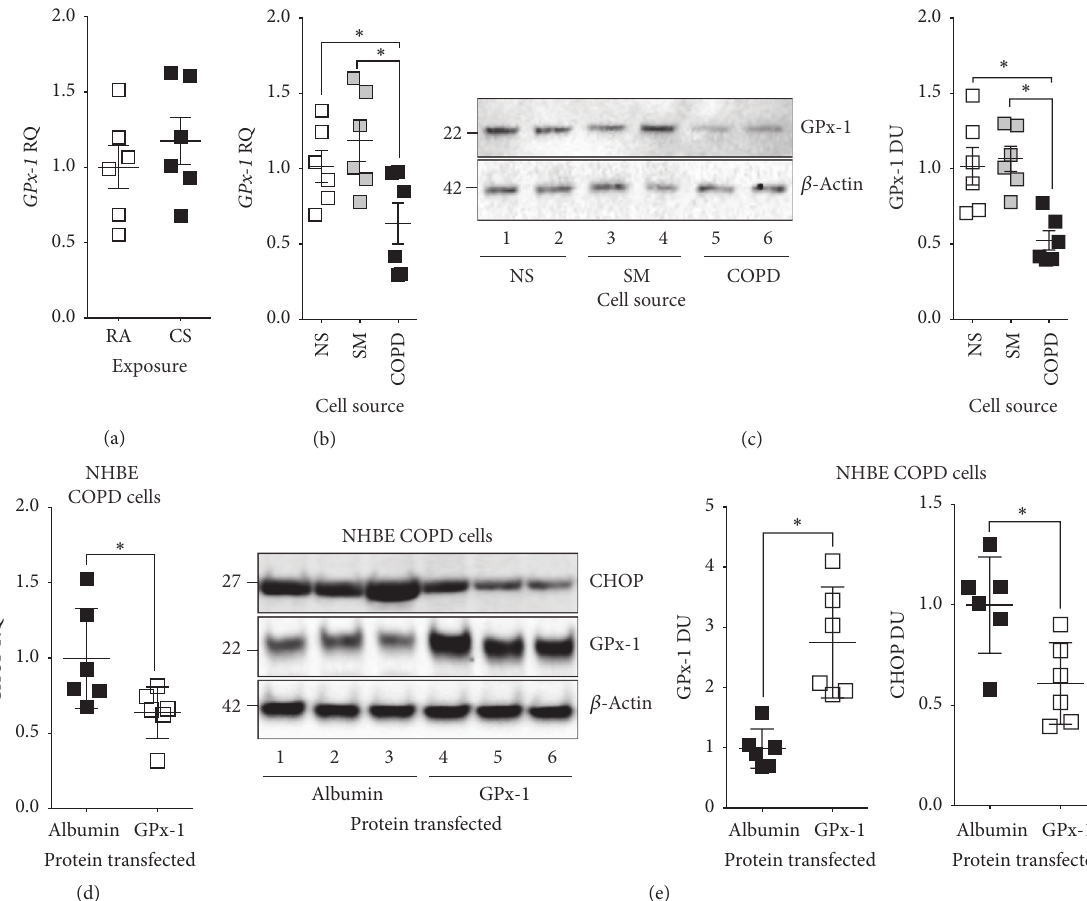
Figure 3: Reintroducing GPx-1 into NHBE cells isolated from COPD donors subdues the UPR. (a) Gene expression of GPx-1 was determined in fully differentiated NHBE cells from nonsmoking individuals ( 𝑛 = 6 ) exposed to room air (RA) and cigarette smoke (CS; from 4 cigarettes every second day (3 exposures)) using a Vitrocell VC-10 smoking robot (b) RNA and (c) protein was analyzed for GPx-1 expression from fully differentiated NHBE cells from nonsmoker (NS), smokers, (SM) and COPD (COPD) individuals ( 𝑛 = 6 donors per group). (d) NHBE cells isolated from COPD subjects were transfected with albumin or GPx-1 protein and CHOP expression was determined by qPCR. (e) Immunoblots and corresponding densitometry analysis for CHOP, Gpx-1, and 𝛽 -actin from NHBE cells from COPD subjects following albumin or GPx-1 protein transfection. In each immunoblot, every lane represents an individual cell donor. Data are shown as mean ± SEM, where each measurement was performed on 3 independent days on 6 donors/group. ∗ denotes a 𝑝 value < 0.05, when comparing both treatments connected by a line, determined by Student’s 𝑡 -test (2 groups) or 2-way ANOVA with Tukey’s post hoc test ( > 2